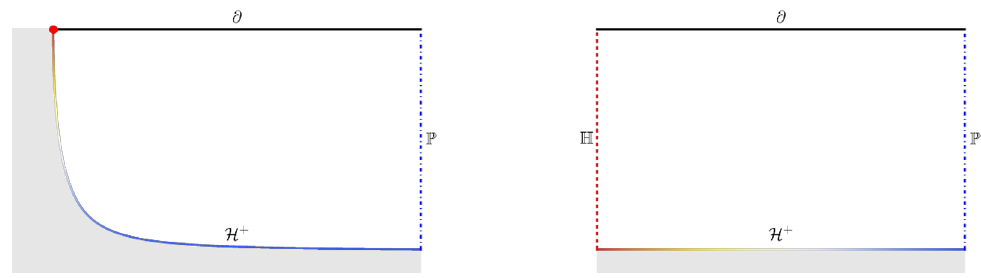
Figure 1 . An illustration of the coordinate transformation mapping the original black funnel triangular domain (left panel), into a square domain (right